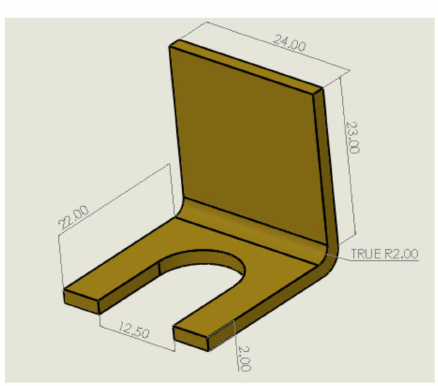
Figure A1. Manufactured Bracket (Dimensions in mm).